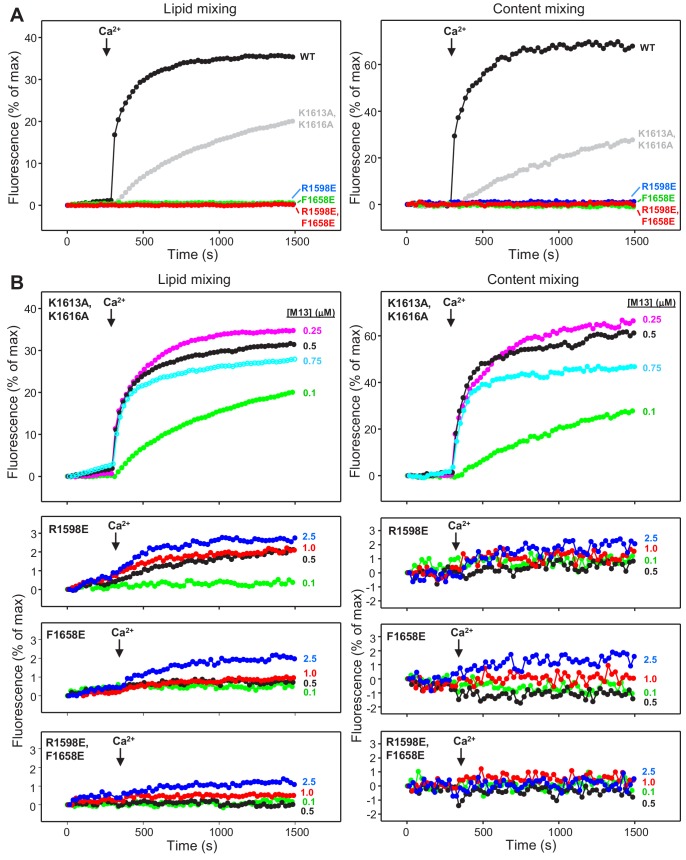
Mutations in putative membrane-binding sites of the Munc13-1 C2C domain disrupt the ability of the Munc13-1 C-terminal region to support liposome fusion in a reconstituted assay.(A) Lipid mixing (left) between V- and T-liposomes was measured from the fluorescence de-quenching of Marina Blue-labeled lipids and content mixing (right) was monitored from the development of FRET between PhycoE-Biotin trapped in the T-liposomes and Cy5-Streptavidin trapped in the V-liposomes. The assays were performed in the presence of Munc18-1, NSF, αSNAP and 0.1 μM concentrations of WT or mutant Munc13-1 fragments, as indicated by the color codes. Experiments were started in the presence of 100 μM EGTA and 5 mM streptavidin, and Ca2+ (600 μM) was added after 300 s. (B) Analogous lipid and content mixing assays performed with different concentrations of mutant Munc13-1 C1C2BMUNC2C fragments as indicated. Note that the scale of the y-axis was expanded in the lower plots to help to visualize the small amounts of lipid and content mixing observed.